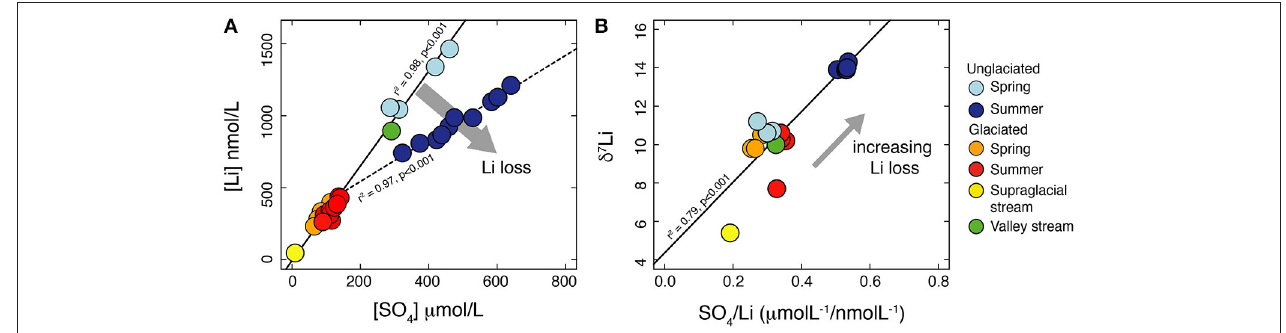
FIGURE 7 | (A) Plot of Li vs. SO 4 concentrations highlighting the relative loss of Li from the summer samples collected from Fardalen (unglaciated catchment) compared to all the other samples. (B) Plot of δ 7 Li vs. SO 4 /Li. The greater the Li loss from solution relative to SO 4 , the greater the δ 7 Li value of the water, consistent with preferential loss of 6 Li during removal processes such as adsorption onto Fe-Mn oxyhydroxides.